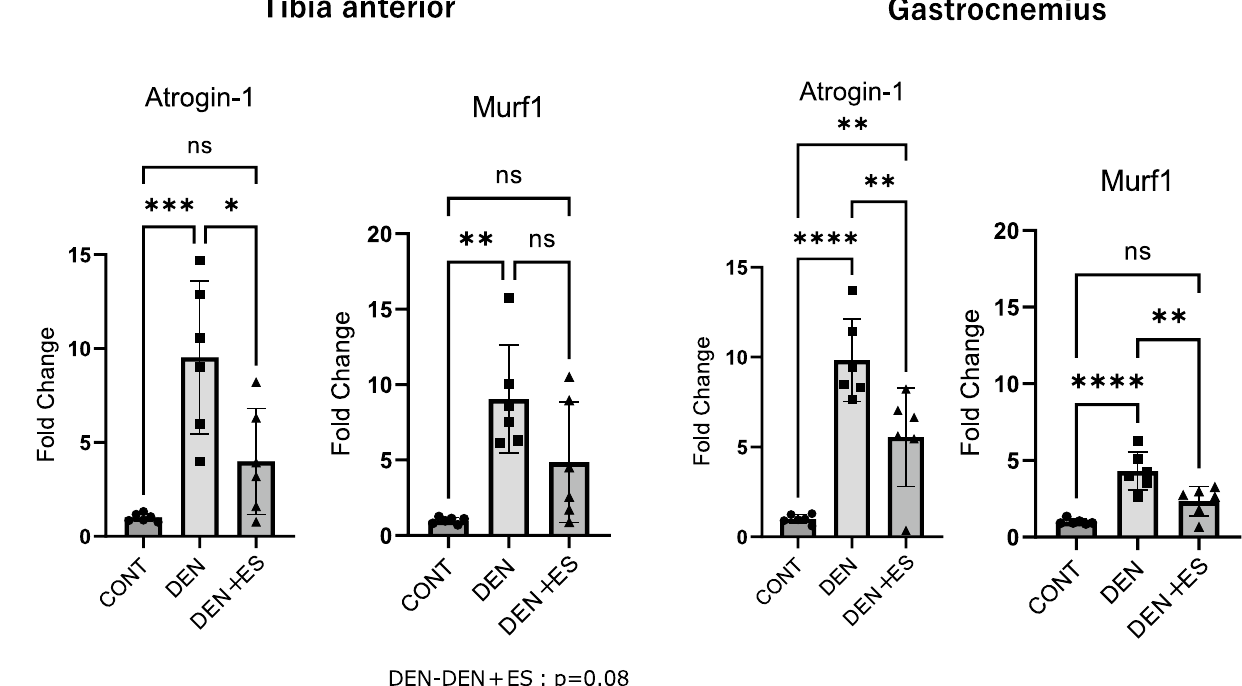
Figure 4. Muscle proteolytic signals of TA and GAS after belt electrode chronic stimulation. Mean ± SD. One- way ANOVA test was used to evaluate changes in proteolytic signals in the lower limb muscles 24 h after chronic stimulation with the belt electrode. CONT, unstimulated control group; DEN, denervation muscle atrophy induced group; DEN + ES, denervation muscle atrophy induced + electrical stimulation by belt electrode group; *p < 0.05, **p < 0.01, ***p < 0.001, ****p <